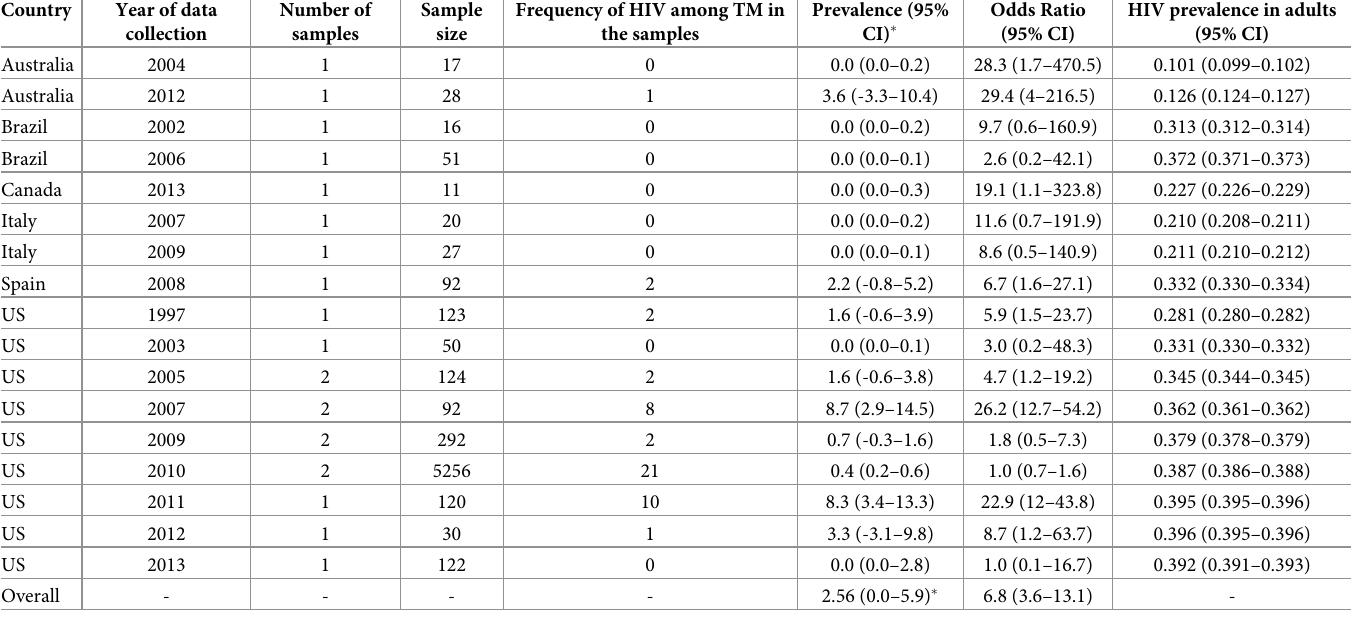
Table 3. Meta-analysis of HIV prevalence in trans masculine individuals compared to all adults (age